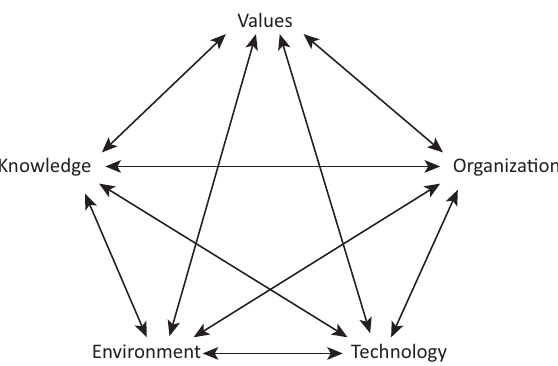
Figure 1. Norgaard’s diagram of co-evolutionary